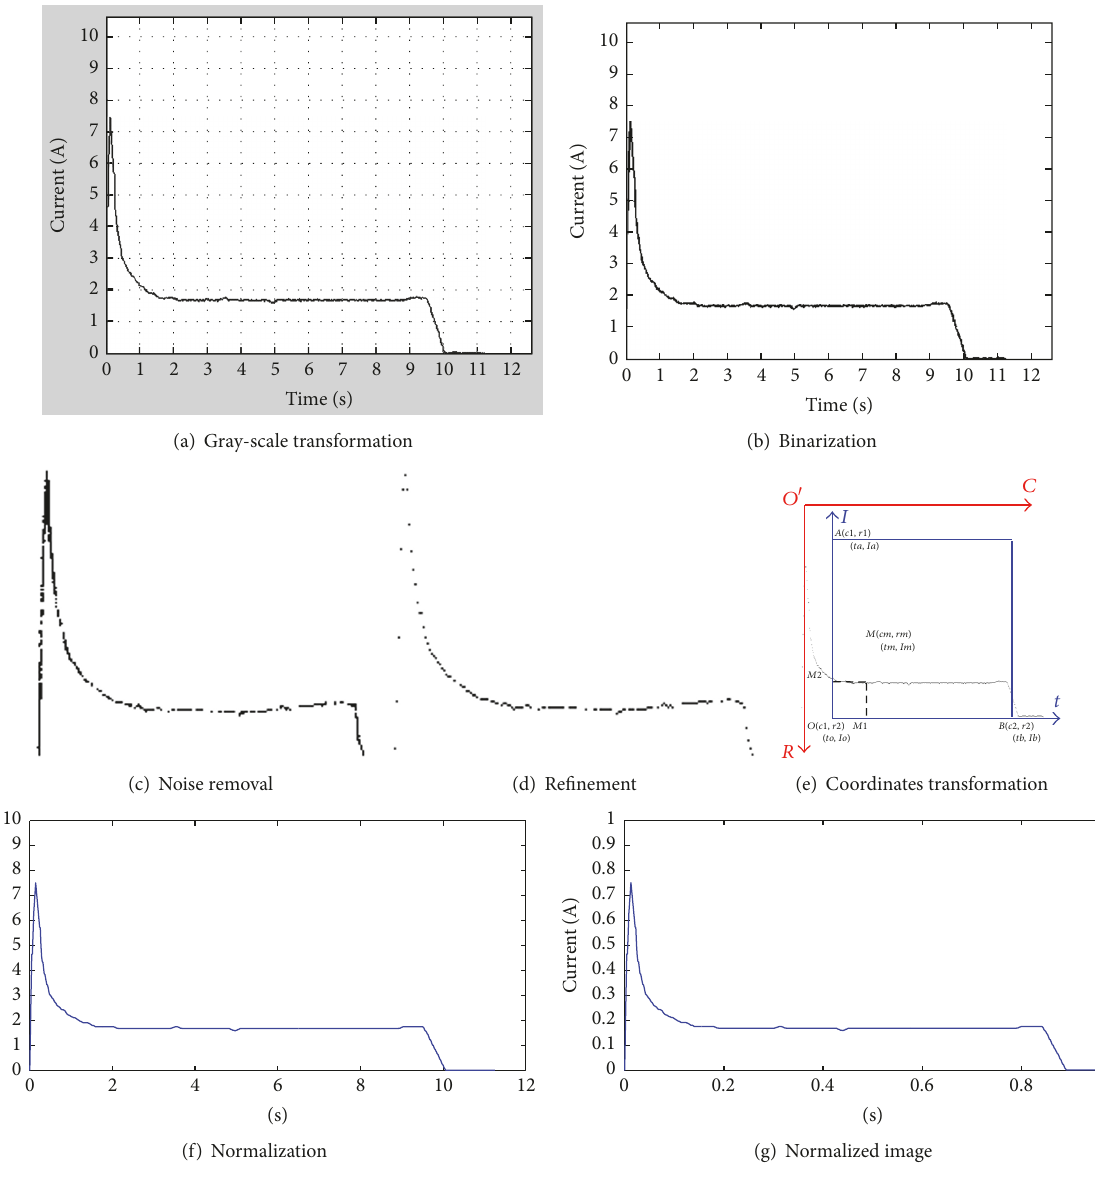
Figure 3: Image normalization